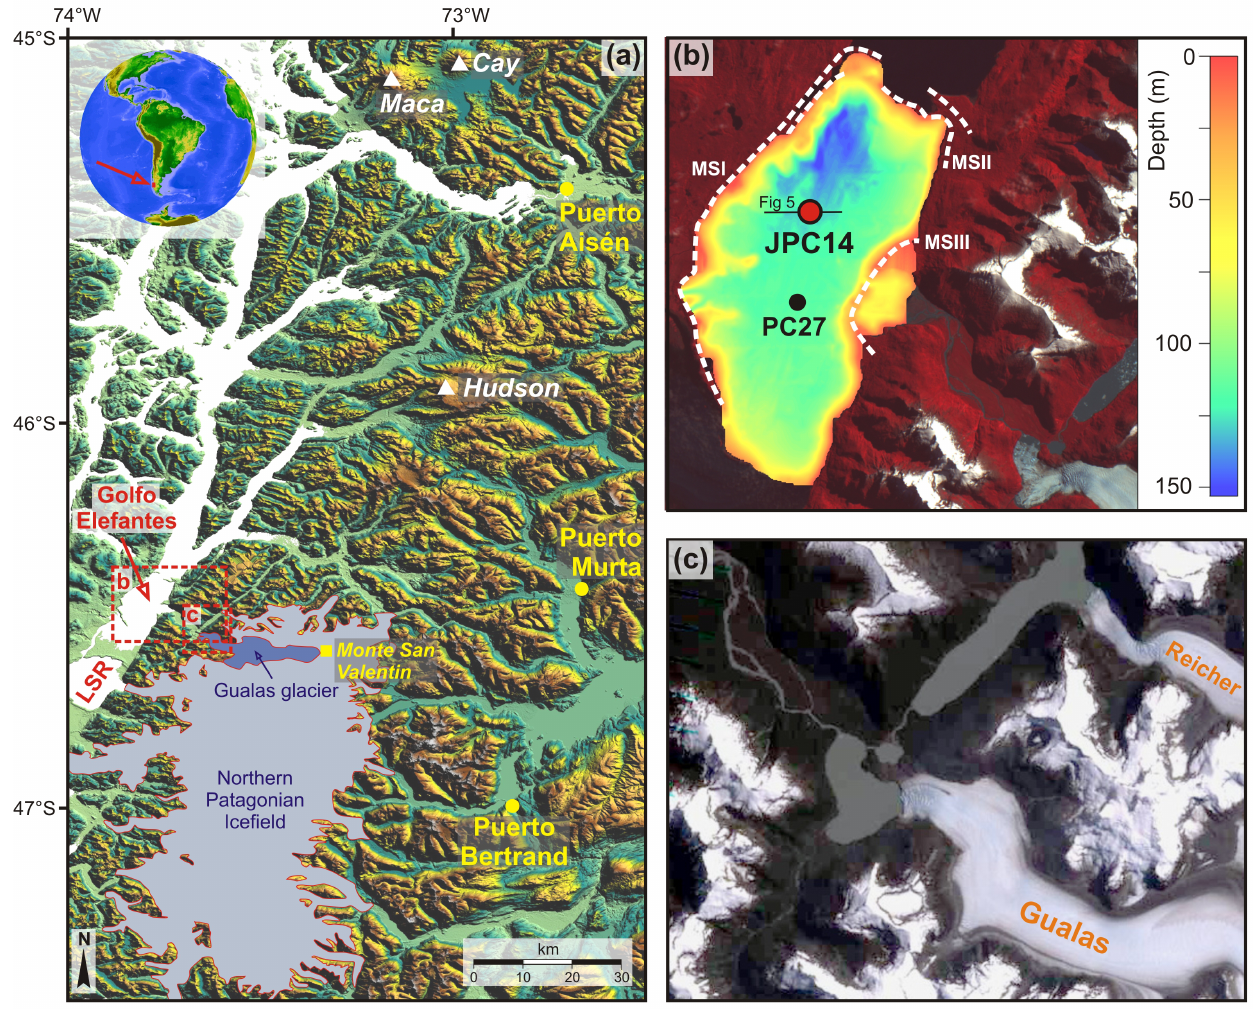
Fig. 1. Location of Gualas glacier and Golfo Elefantes in Northern Chilean Patagonia. (a) Regional map with indication of the main towns ( • ) and regional volcanoes ( 1) . LSR: Laguna San Rafael. (b) Location of sediment cores JPC14 and PC27 in Golfo Elefantes. The background is a false color 2001 Landsat image (bands 2, 3, 4) where dense vegetation is represented by bright red colors. Bathymetrical data are from SHOA (Hydrographic and Oceanographic Service of the Chilean Navy; bathymetric map Golfo Elefantes and Laguna San Rafael) and from Fernandez et al. (2012). The location of seismic line 5 (see Fig. 5) is also indicated. MSI, II and III refer to Gualas Moraine systems I, II and III, according to Heusser (1960) and Fernandez et al. (2012). (c) Landsat image (16 February 2010) of the ice fronts of Gualas and Reicher